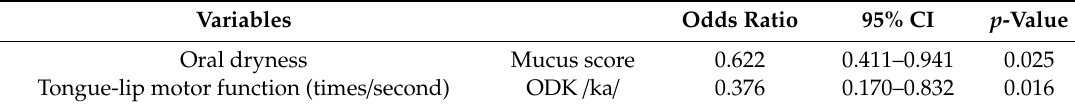
Table 4. Adjusted odds ratios and 95% CIs for low GOHAI score.